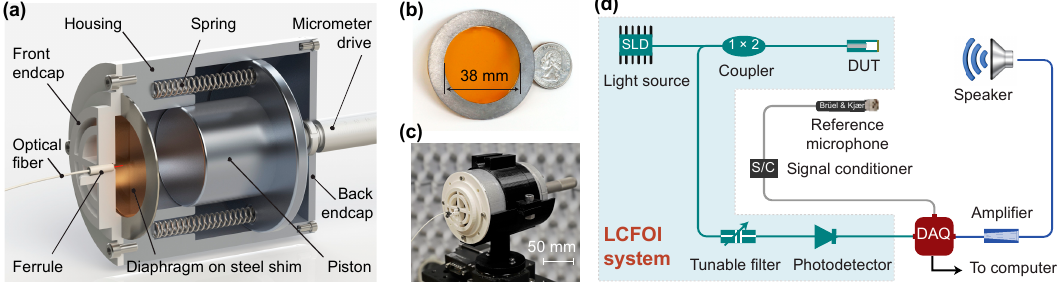
Figure 2. Experimental design to investigate the acoustics–structure interaction between a diaphragm and its backing cavity. ( a ) Schematic of the setup to vary the backing air cavity length. ( b ) Photo of the polyimide diaphragm with its edge glued to a circular steel shim (next to a dime). ( c ) Photo of the integrated device under test (DUT) mounted on a stage. ( d ) Schematic of the measurement system including a low-coherence fiber-optic interferometer (LCFOI) system in the shaded area. DAQ: Data acquisition card, SLD: superluminescent diode.